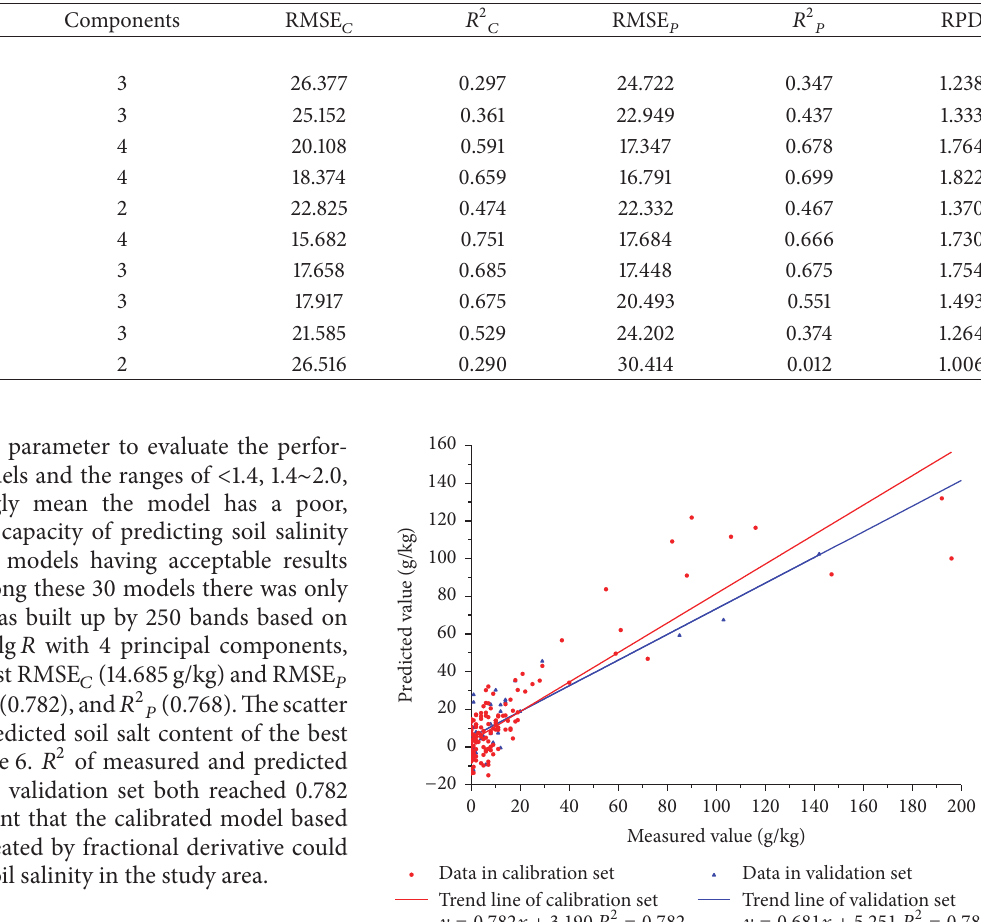
Table 5: The results of the PLSR models based on lg 𝑅 .